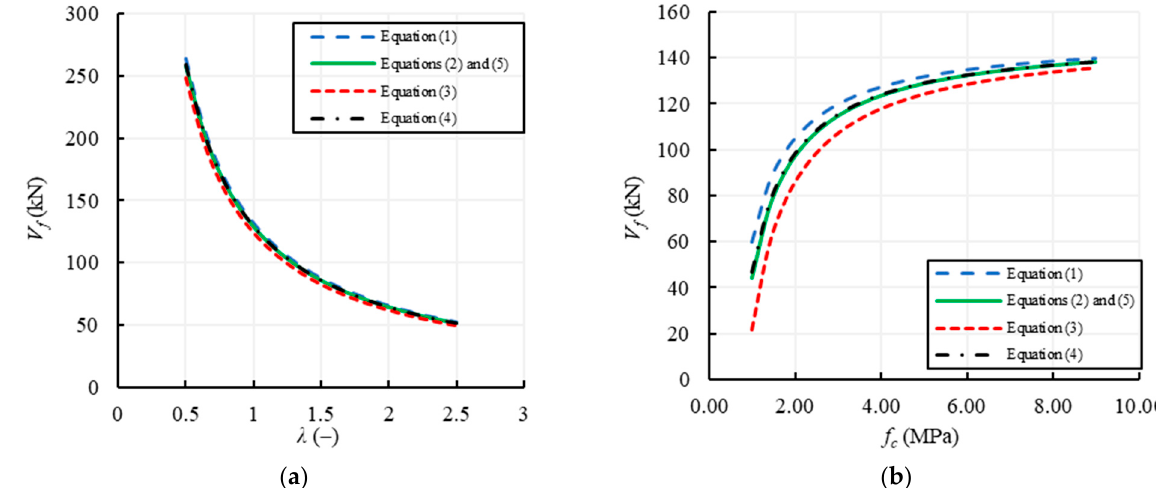
Figure 6. Sensitivity analysis of the flexural capacity provided by several formulations in the function of the: ( a ) wall slenderness, λ ; ( b ) masonry compressive strength, f c .